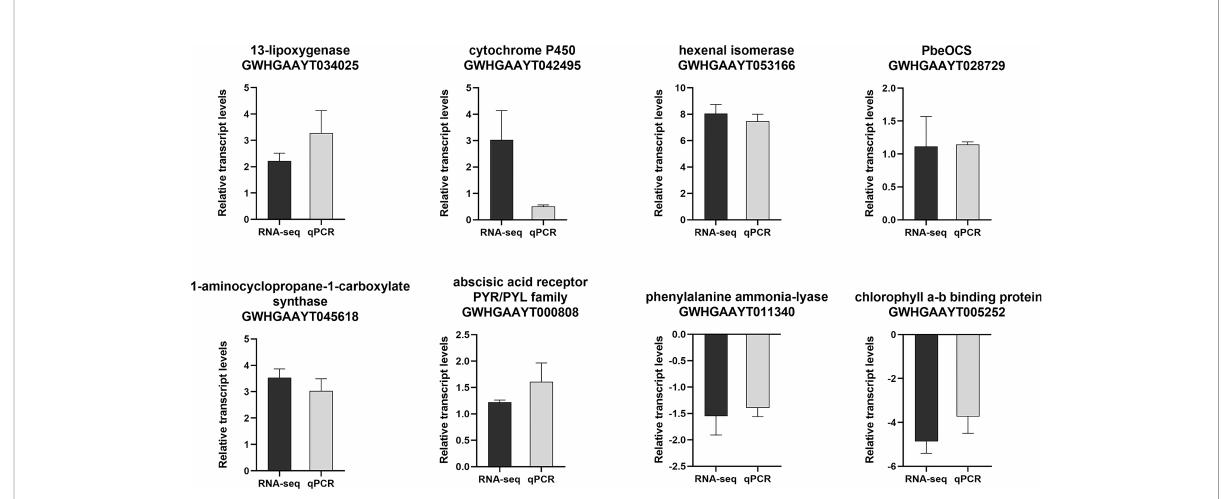
FIGURE 3 The relative expression levels of selected genes from the RNA-seq (black bar) and qPCR (gray bar)